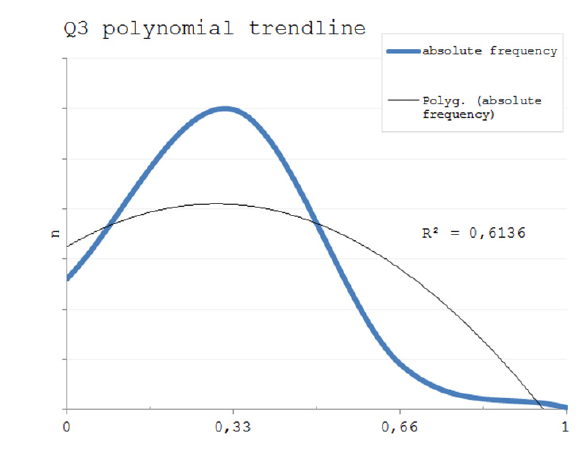
Fig. 3 - Q3 line chart with trendline. Source: authors